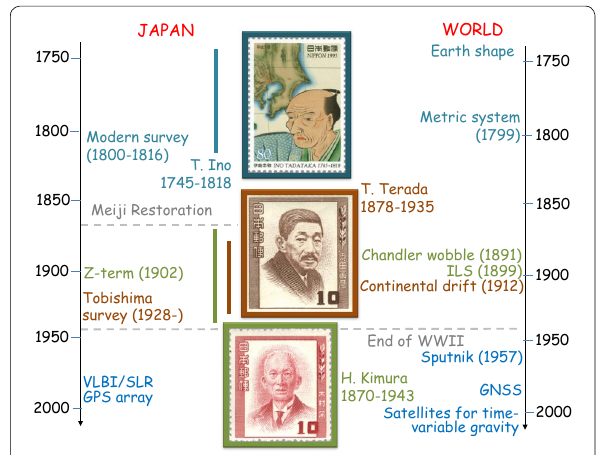
Fig. 1 History of geodesy in Japan. The three pioneers in Japanese geodesy and geodynamics, Ino, Kimura, and Terada, and related events in Japan and the world mentioned in this article